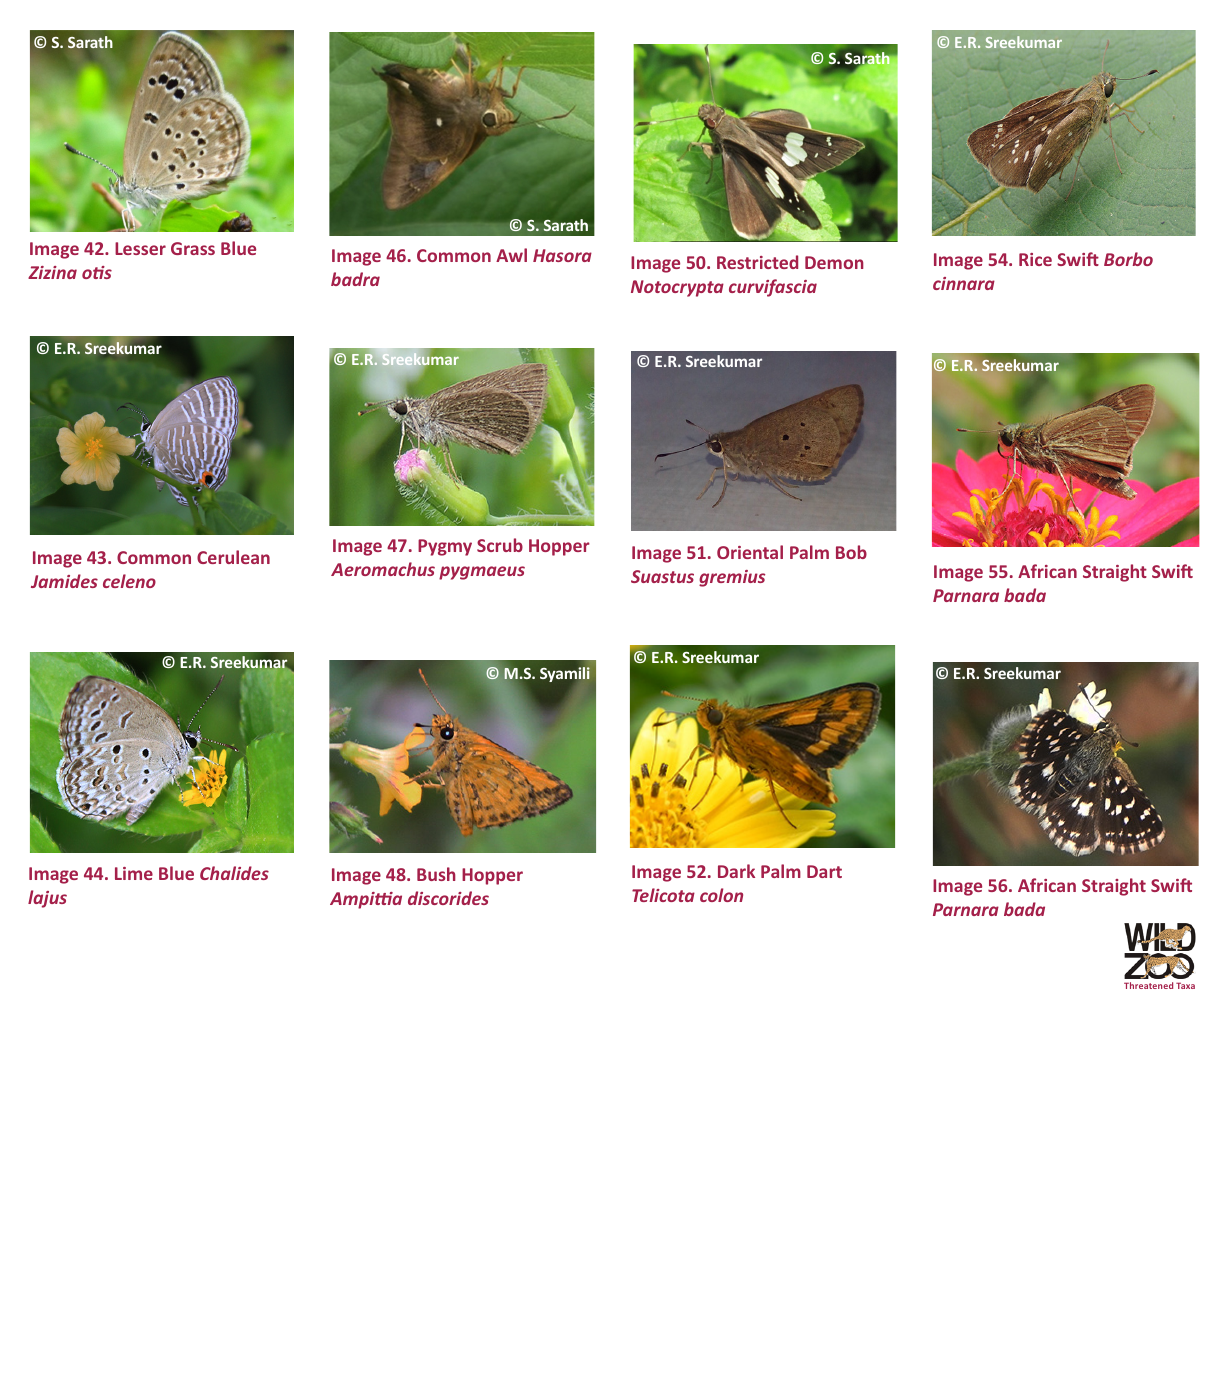
Image 53. Lesser Rice Swift Borbo bevani